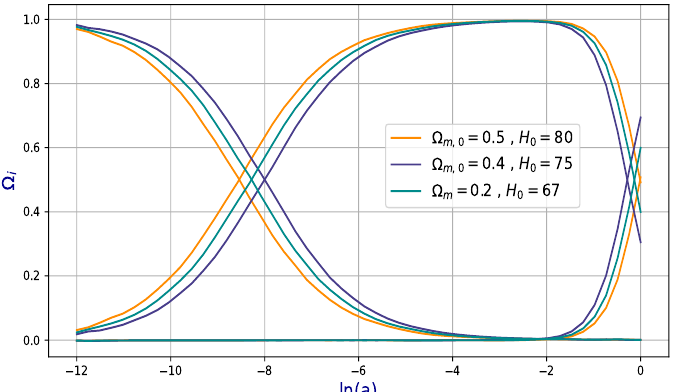
Figure 7. Predictions for different initial conditions, evaluating the ANN model instead of fully solving the differential